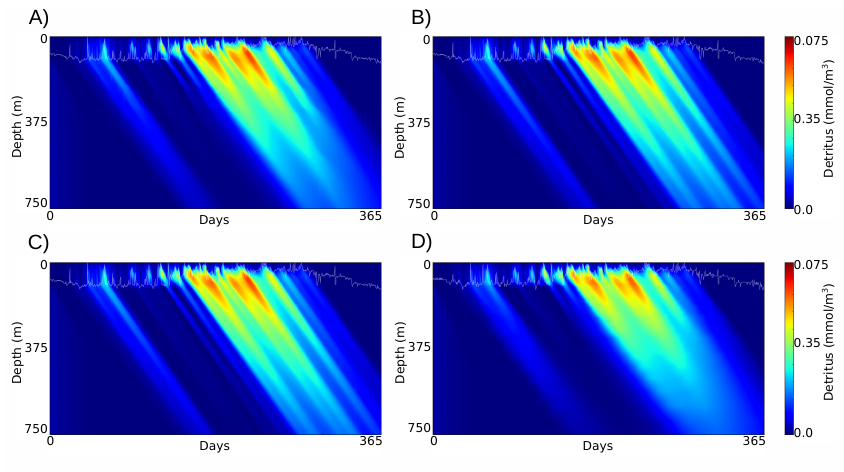
Fig. 16. Time–depth plot of detritus at Station Papa from the original adaptive mesh simulation (A) , the adaptive run with detritus included in the metric (B) , the high-resolution fixed-mesh simulation (C) , and (D) the same simulation using decreasing resolution with increasing depth. Including detritus in the adaptive metric increases the performance of the model at tracking detritus to depth, resolving detail in the timing and level of detrital pulses. Note that (D) smooths those events into a single unresolved event by day 300.